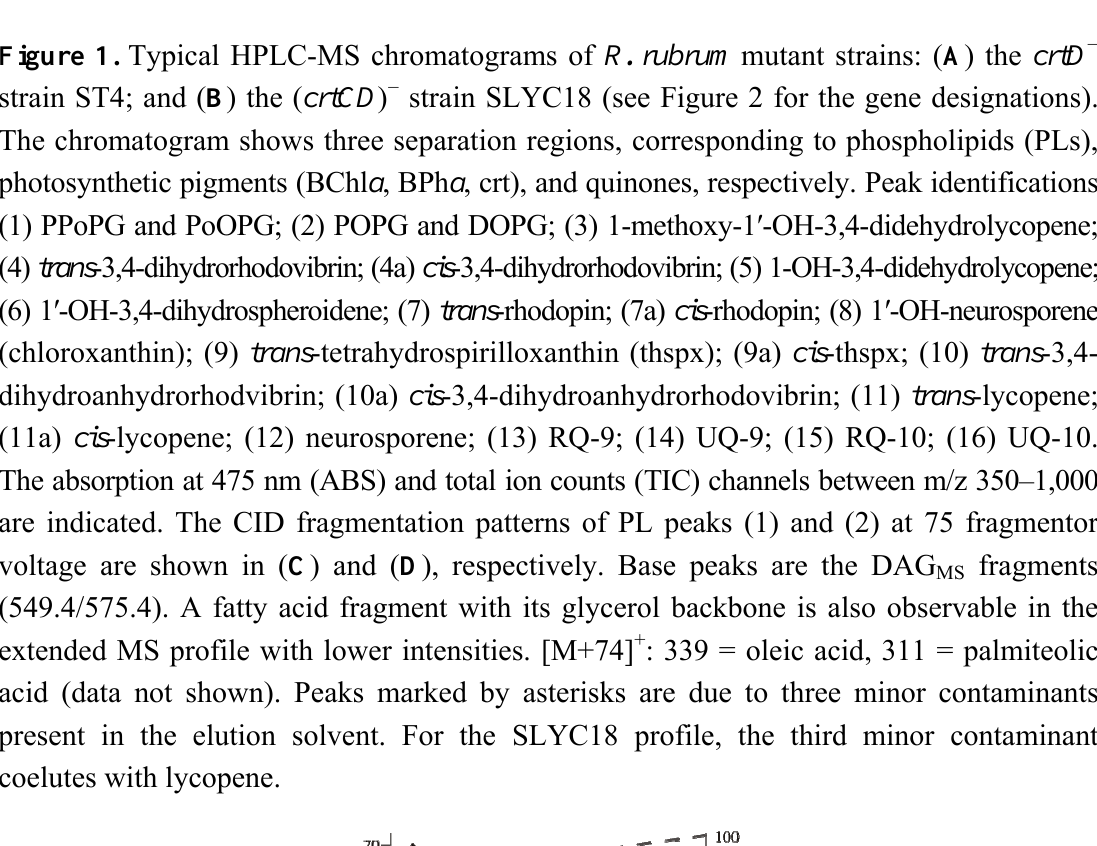
Figure 1. Typical HPLC-MS chromatograms of R. rubrum mutant strains: ( A ) the crtD